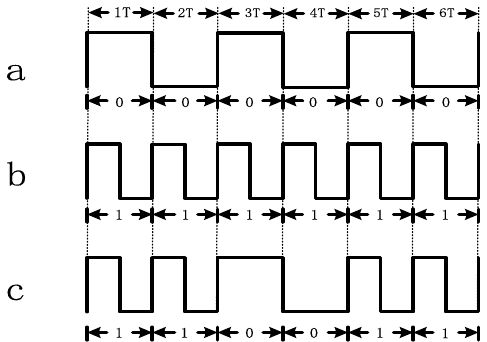
Figure 1. F2F coding rule. ( a ) If there is no flux in one period (T), then the signal is recorded as “0”. ( b ) If there is a flux in one period (T), then the signal is recorded as